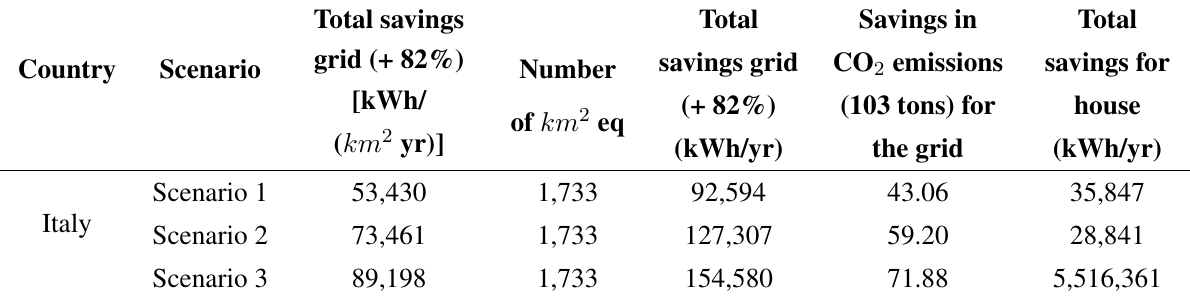
Table 9. Global (grid + houses) savings in the grid and global reduction of carbon dioxide